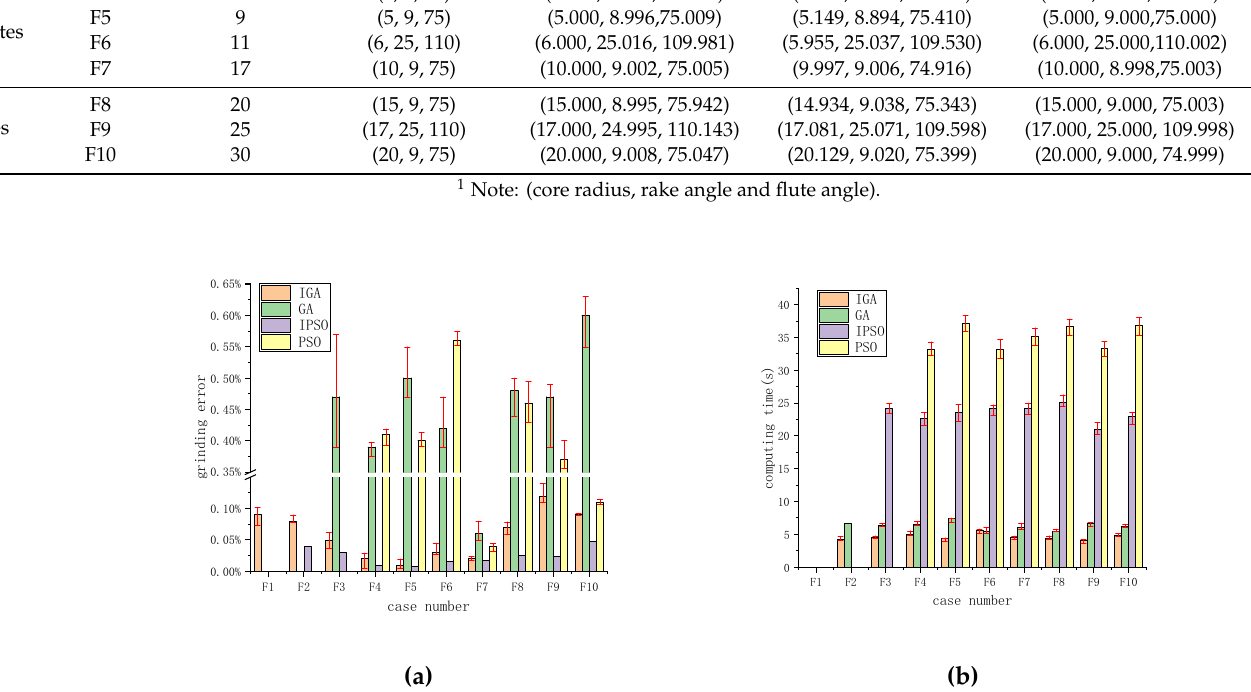
Figure 7. Comparisons with various algorithms: ( a ) the grinding errors; ( b ) the computing time.